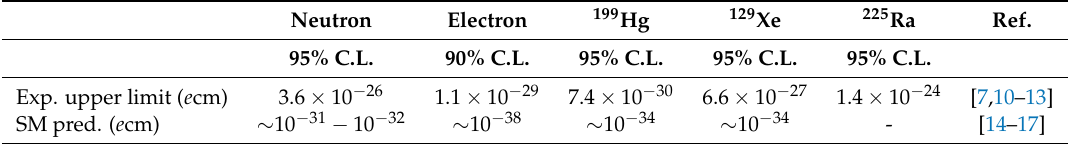
Table 1. Summary of published experimental upper limits and Standard Model (SM) predictions for several systems of fundamental particles and atoms used in electric dipole moment (EDM) searches. Experimental results are far beyond SM predictions but are within reach of beyond SM theories to constrain model